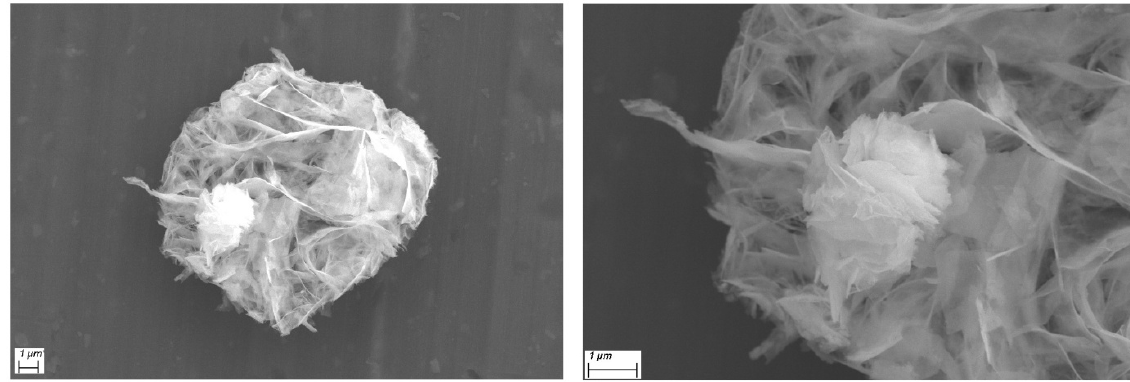
Figure 3. SEM images of Bi 2 O 2 CO 3 .